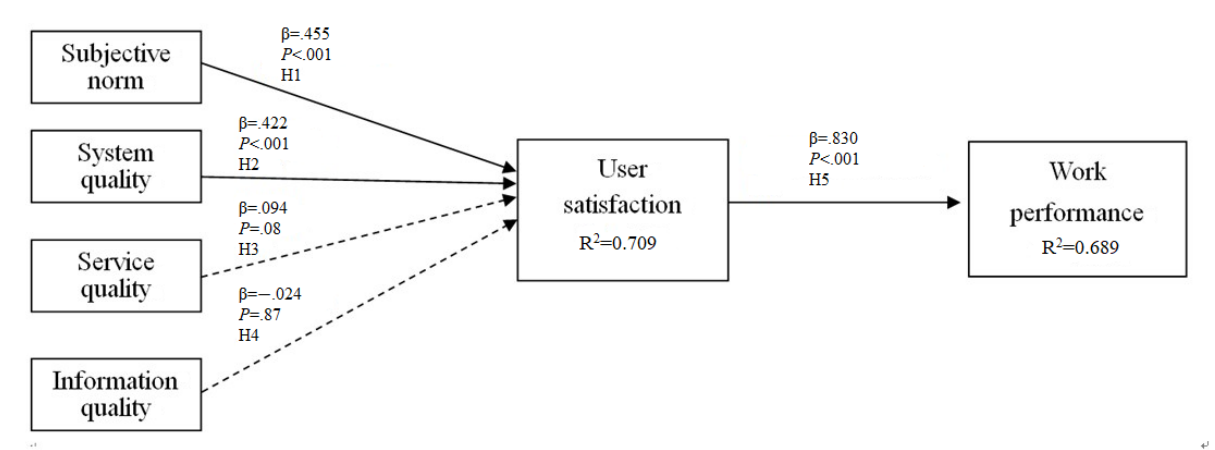
Figure 2. Results of the research model and hypothesis